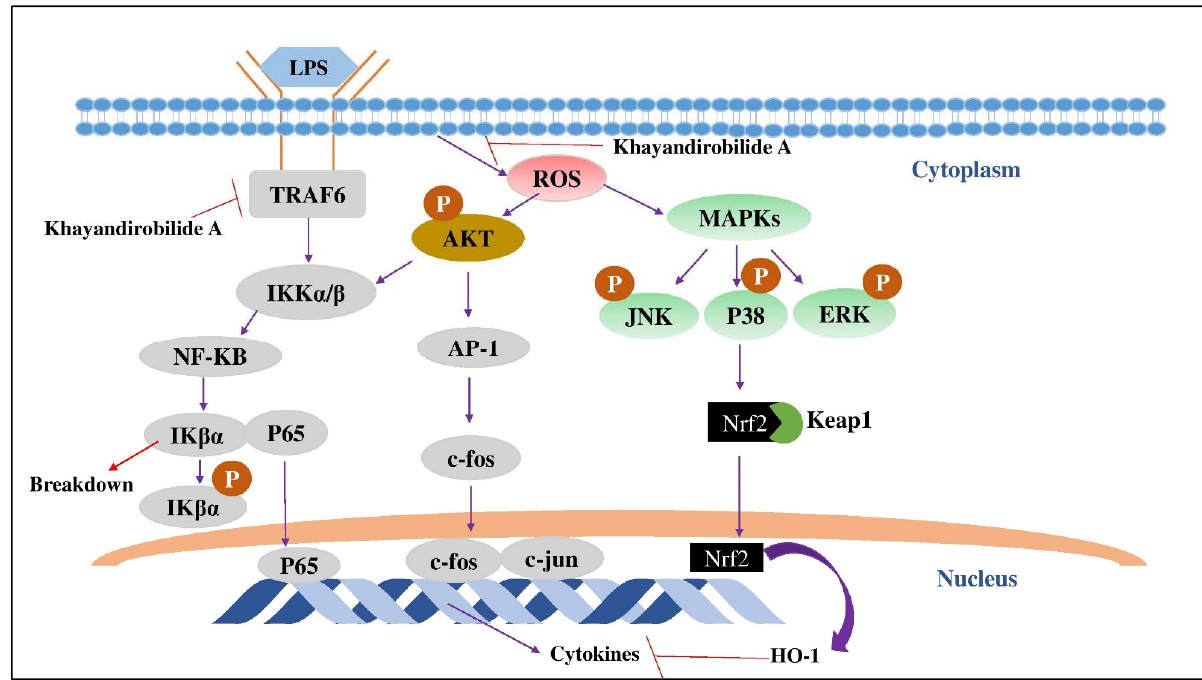
Figure 6. Mechanism of Nrf2-ARE activation by KLA. The diagram was adapted and modified from Zhou, M.-M. et al., 2018 [40].